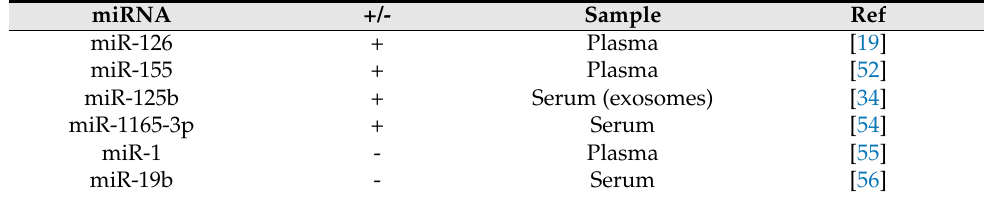
Table 4. miRNAs studied in the blood that can serve as severity-risk assessment panel. miRNA